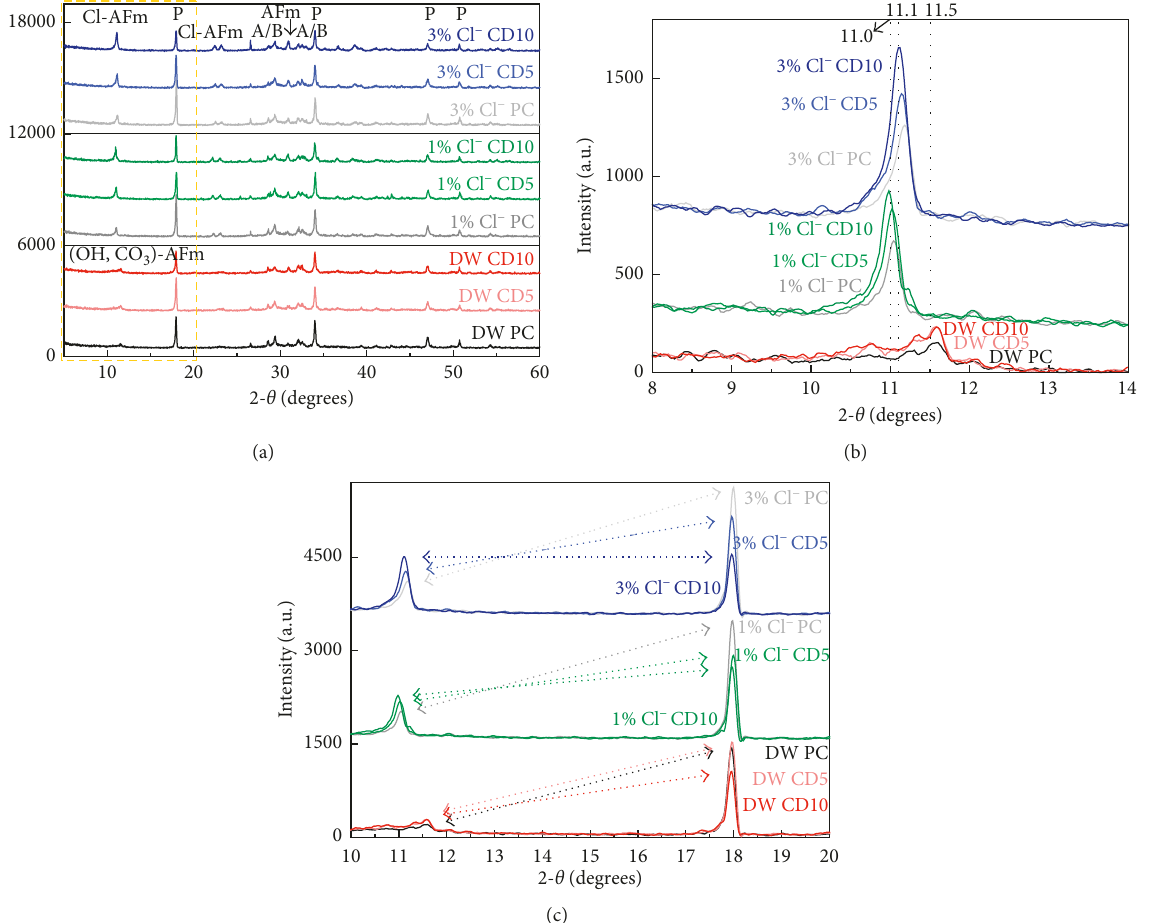
Figure 10: XRD patterns of PC, CD5, and CD10 reacted with distilled water or chloride solution at 28 days. (a) The XRD patterns between 5 ° and 60 ° . (b) The XRD patterns between 8 ° and 14 ° . (c) The XRD patterns between 10 ° and 20 ° ; P: Ca(OH) 2 , A/B: C 3 S and C 2 S, and AFm: AFm phases.